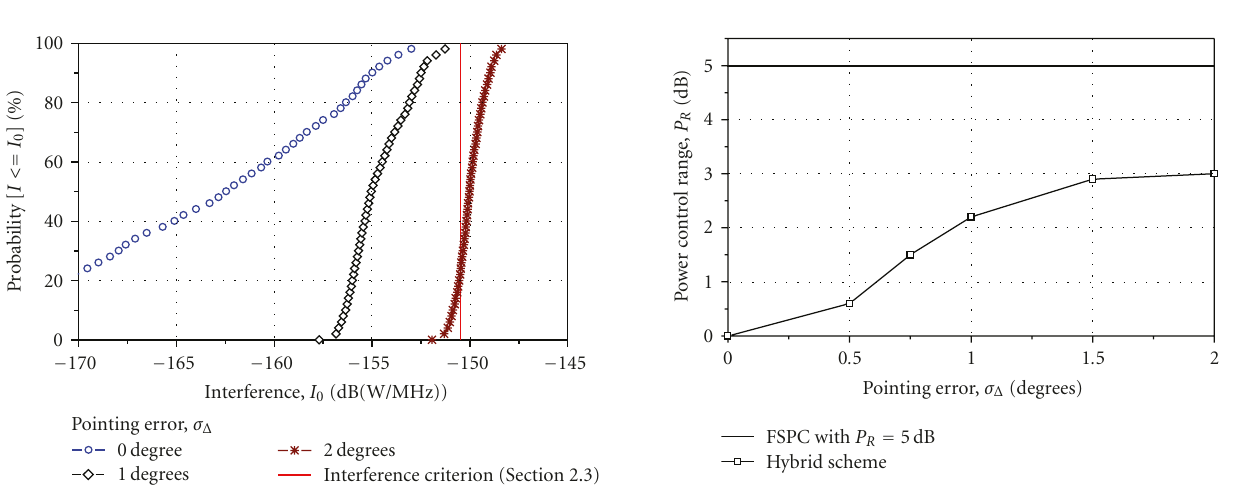
Figure 15: CDF of interference levels according to the pointing errors, σ Δ .